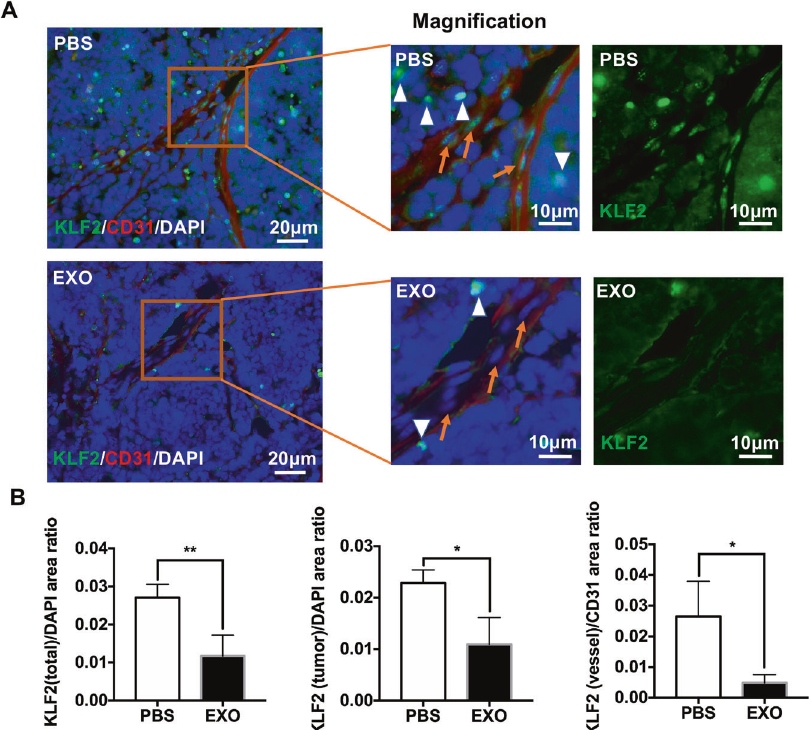
Fig. 8 Exosomes derived from WERI-Rb1 cells decrease the expression of KLF2 both in tumor tissues and vessels. A CD31 (red) and KLF2 (green) were labeled by immuno fl uorescence in tumors from the PBS ‐ injected or EXO ‐ injection groups. White arrowheads: KLF2 in the tumor tissue, orange arrows: KLF2 in the vessels, scale bar, 20 or 10 μ m. B Quanti fi cation data showed KLF2(total)/DAPI area ratio, KLF2(tumor)/DAPI area ratio, and KLF2(vessel)/CD31 area ratio from the PBS ‐ injected and EXO ‐ injected groups ( n = 5, * P < 0.05, ** P <